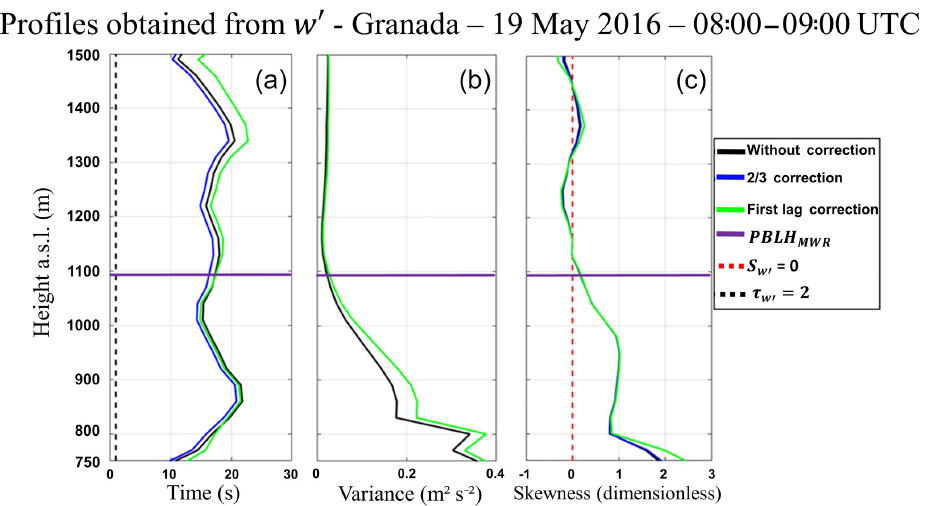
Figure 5. (a) Vertical profile of integral timescale ( τ w (cid:48) ). (b) Vertical profile of variance ( σ 2 profiles were obtained from Doppler lidar data on 19 May 2016 from 08:00–09:00UTC in Granada.